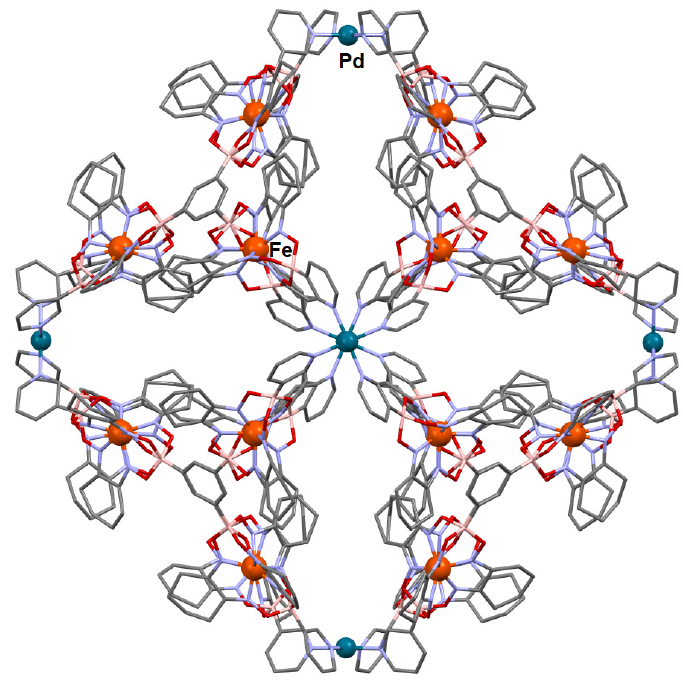
Figure 11. The crystal structure of [Pd 6 L 8 ](BF 4 ) 12 (L = 14)